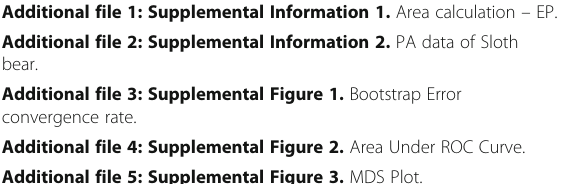
Additional file 3: Supplemental Figure 1. Bootstrap Error convergence rate. Additional file 4: Supplemental Figure 2. Area Under ROC Curve. Additional file 5: Supplemental Figure 3. MDS Plot.